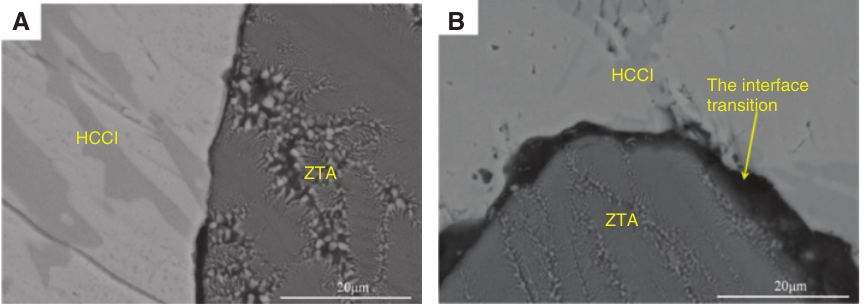
Figure 5: SEM images of the composite interface: (A) S